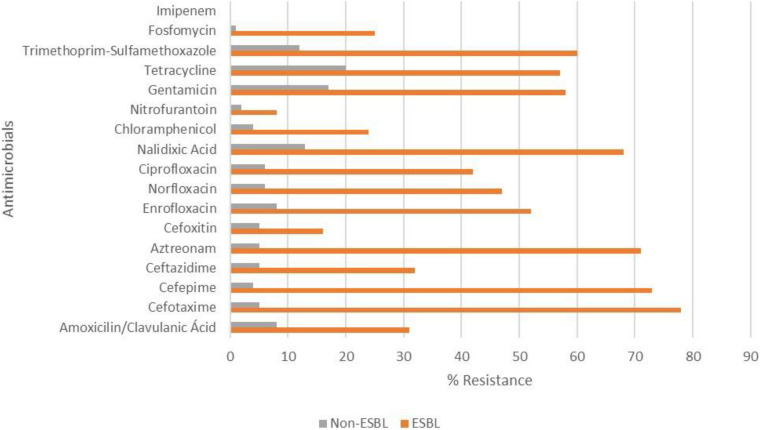
Resistance of ESBL-producing and non-ESBL-producing E. coli strains isolated from poultry farms in southern Brazil. There were significant differences between ESBL-producing and non-producing strains (p < 0.05), except for cefoxitin, nitrofurantoin and imipenem (all isolates were sensitive).